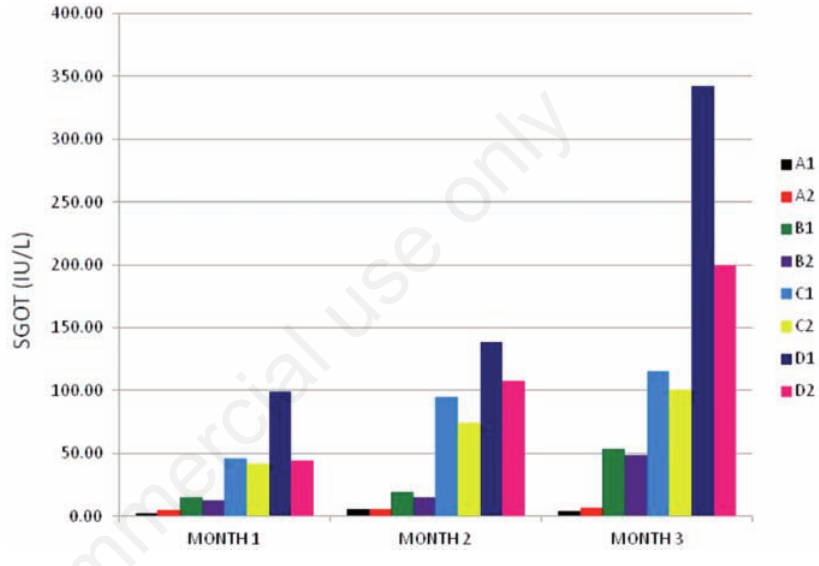
Figure 1. Aspartate aminotransferase (SGOT enzyme) activity values for 3 months study period.